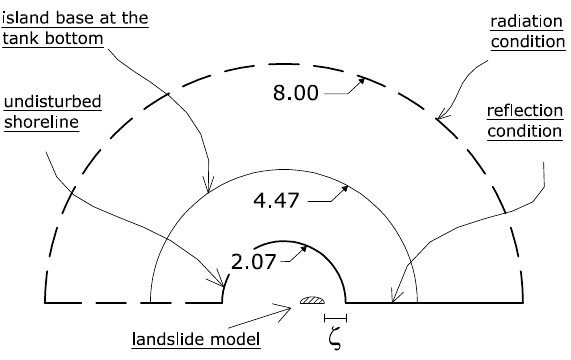
Fig. 4. Numerical domain of the depth integrated model. The numbers 2.07, 4.47 and 8.00 express the radii in meters of respectively the undisturbed shoreline, the island base at the tank bottom, and the external circular boundary.